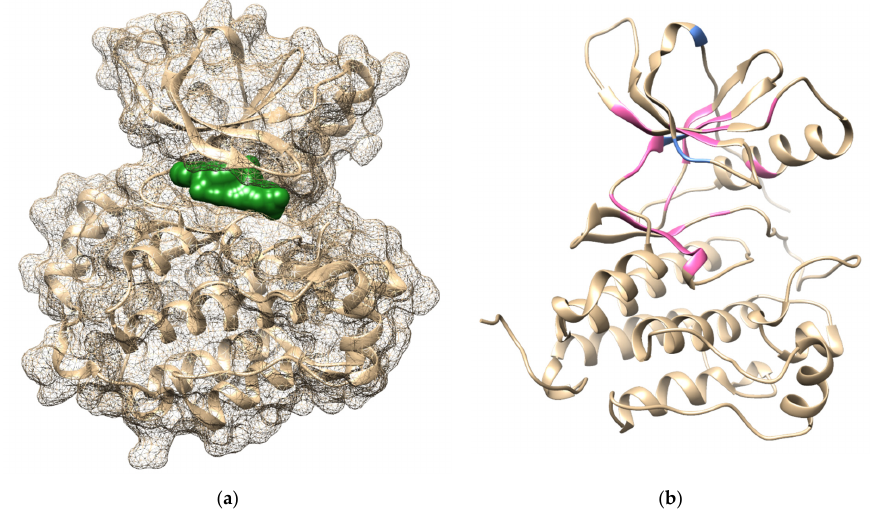
Figure 4. ( a ) Binding pocket of ANP-Mg in EGFR based on 5D41 crystal structure; ( b ) Mutation position of the reference mutation (blue) and test mutation (pink) on 1M17 crystal structure. The position of Mg was retained from the ANP phosphate groups in the optimum position based on the previous research [27], and an optimized structure was used for the interaction study. Based on the result of the molecular dynamic simulation, all complexes of the mutated EGFR with ANP showed stable conformation during the last 50 ns simu- lation. The binding energies of the ligand against 25 mutated EGFR were compared to the wild-type complex, as shown in Table 2. The positive binding energy difference ( ΔΔ G) means that the ANP affinity is predicted to be lower, while negative ΔΔ G predicts a higher affinity to the mutated receptor. Table 2. Free binding energy of ATP to mutated EGFR. EGFR